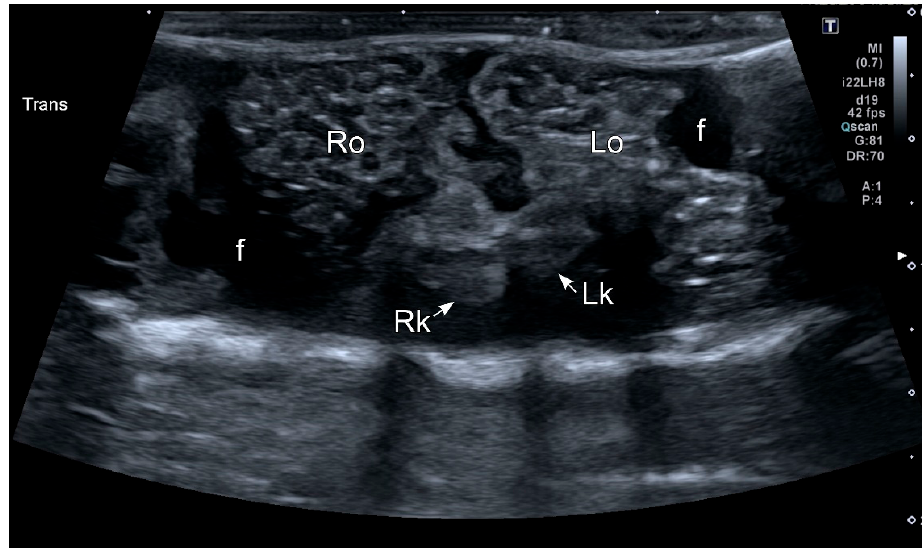
Figure 6. HR-US image of a female Kaloula pulchra obtained in the transverse plane using a ventral acoustic window. The image was taken just after oviposition. Both ovaries (right ovary: Ro; left ovary: Lo) appeared as hyperechoic structures with multiple hypoechoic foci which represent follicles. The kidneys are also visible (right kidney: Rk; left kidney: Lk). This animal had free fluid (f), which is considered normal in amphibians. The fluid around the ovaries improves its margin definition.